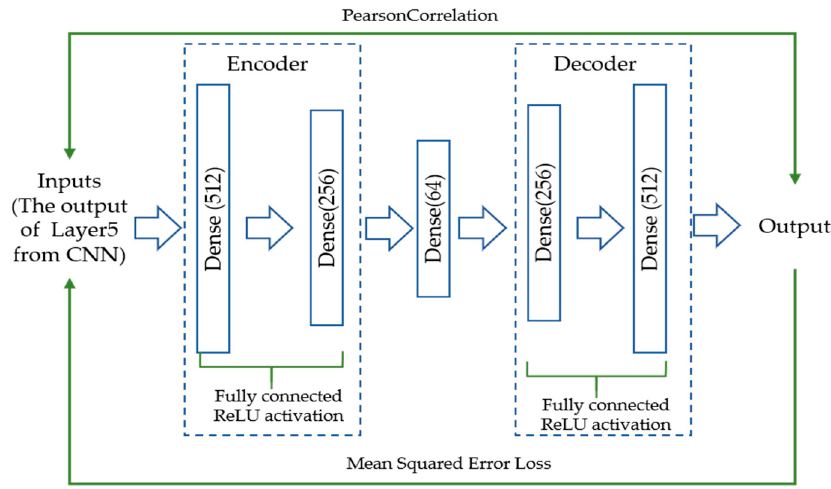
Figure 5. The architecture of the discriminant network using multiple autoencoders.